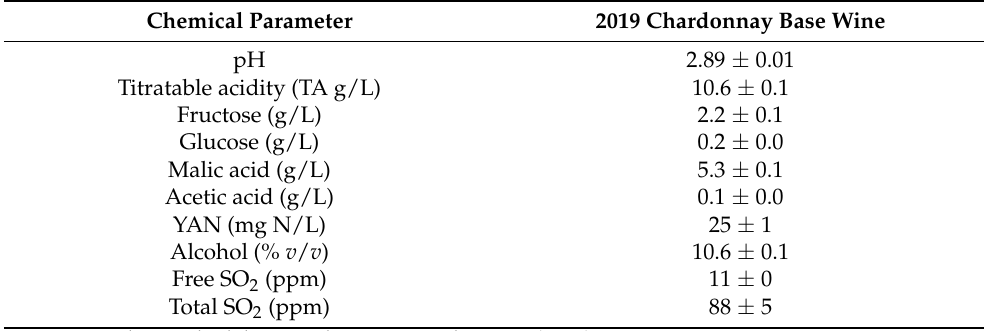
Table 3. Base wine chemical composition analyzed prior to treatment additions. Chemical